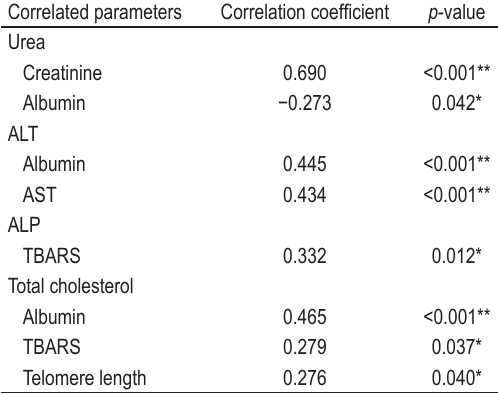
TABLE 2. Correlation between clinical parameters measured in 56 participants using spearman rank correlation coefficient Correlated